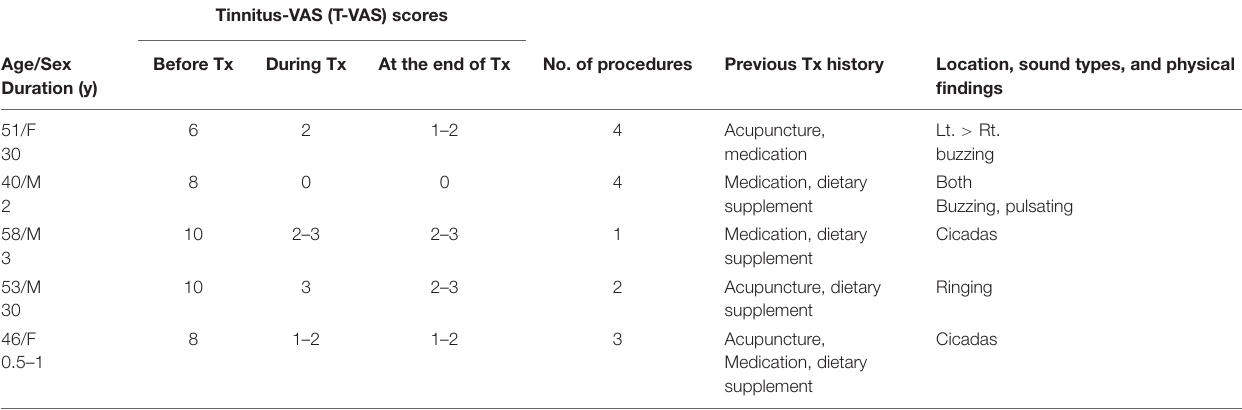
TABLE 6 | Demographic data, visual analog scale (VAS) scores, and clinical data in excluded chronic tinnitus